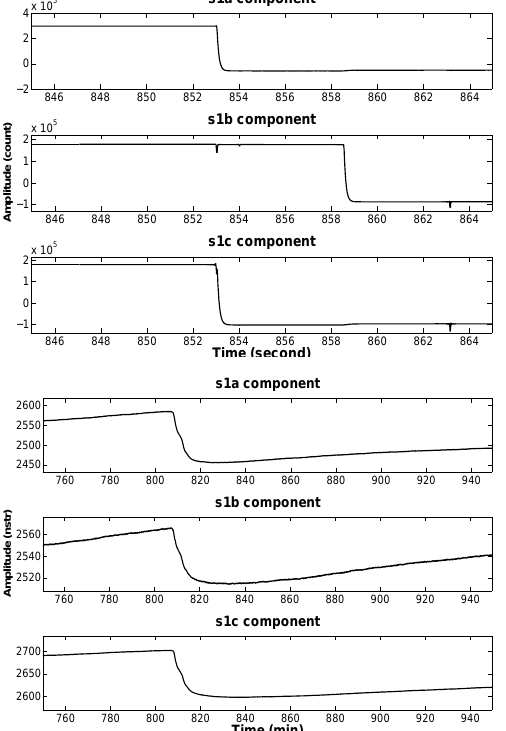
Figure 3. (a) 20 seconds of MOK strain records (50 Hz sampling). The compression is positive and the amplitude is giving in count (D.U). The steps related to valves opening are ex- tensive with an amplitude around 3. 10 5 D.U for each com- ponent. (b) 3 hours of MOK strain records exhibiting slow strain variations related to fracturing process close to the sensor. The amplitude is giving in nanostrain (see Tab. 2 for calibration coefficients).